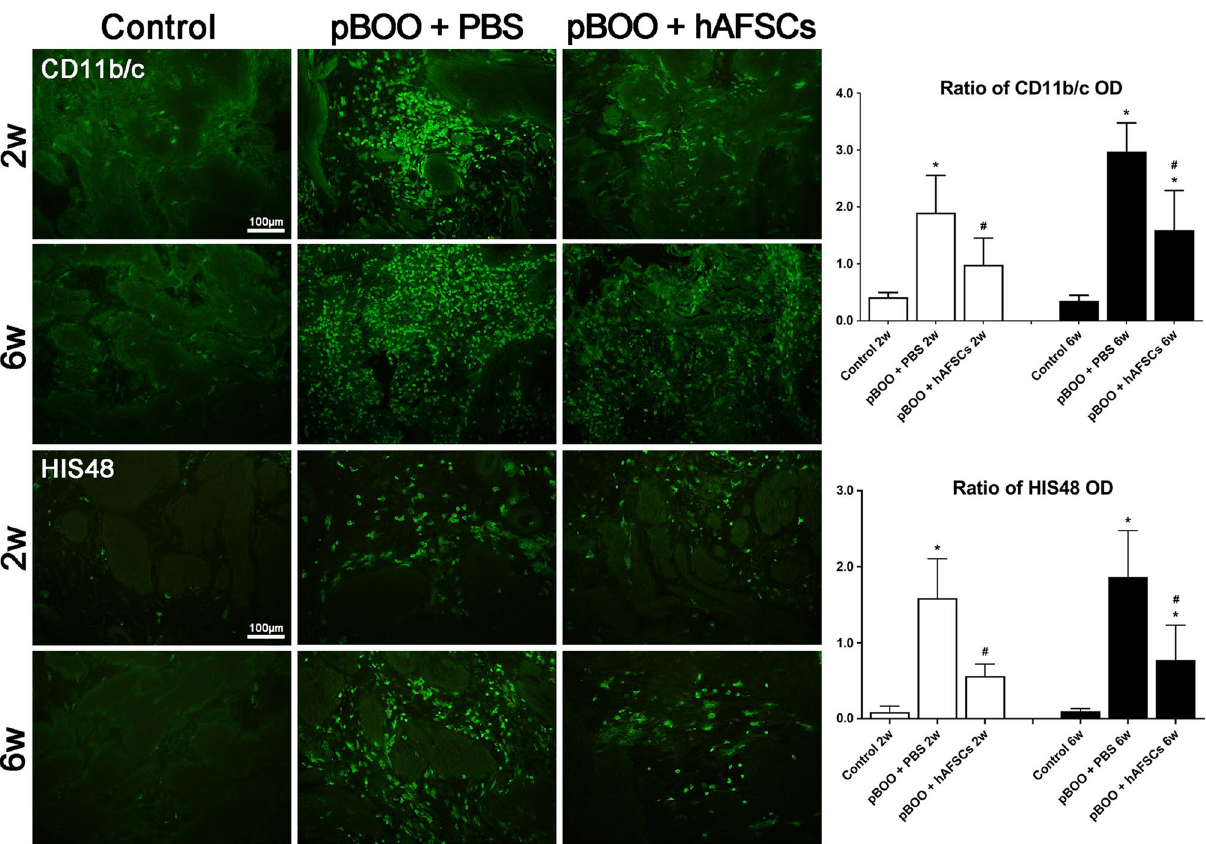
Figure 6. Myeloid-derived suppressor cells (MDSCs) are stained positive for both CD11b/c and HIS48 in bladder at different time points after pBOO and hAFSCs treatment. The levels of positive CD11b/c and HIS48 stained MDSCs are increased in the pBOO group compared with the control group and decreased at 2 and 6 weeks after hAFSCs treatment. *: P < 0.05 vs. control, #: P < 0.05 vs. pBOO + PBS. N = 6 in each time point. Bar indicates 100